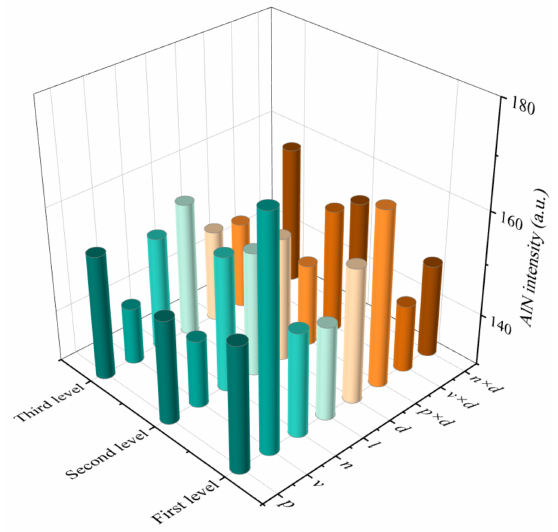
Figure 7. AlN phase range analysis